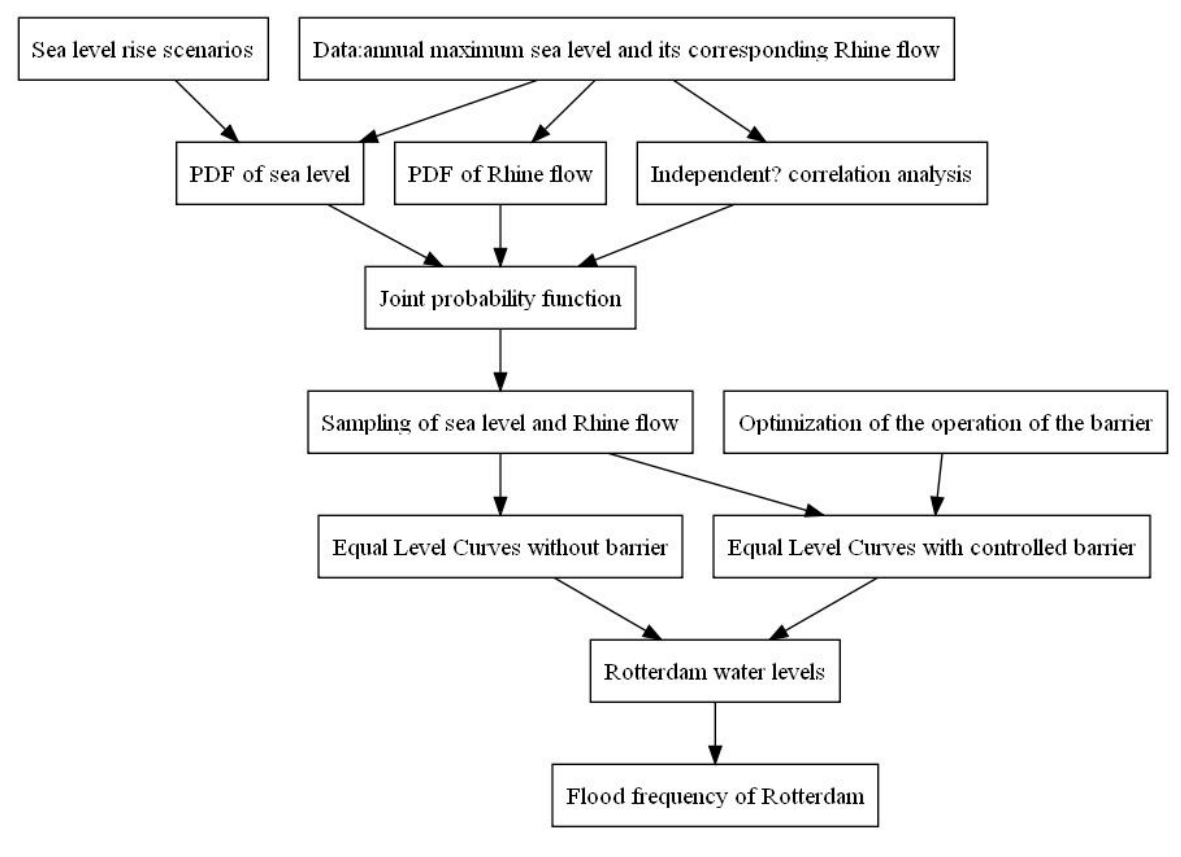
Figure 4. Flow chart of